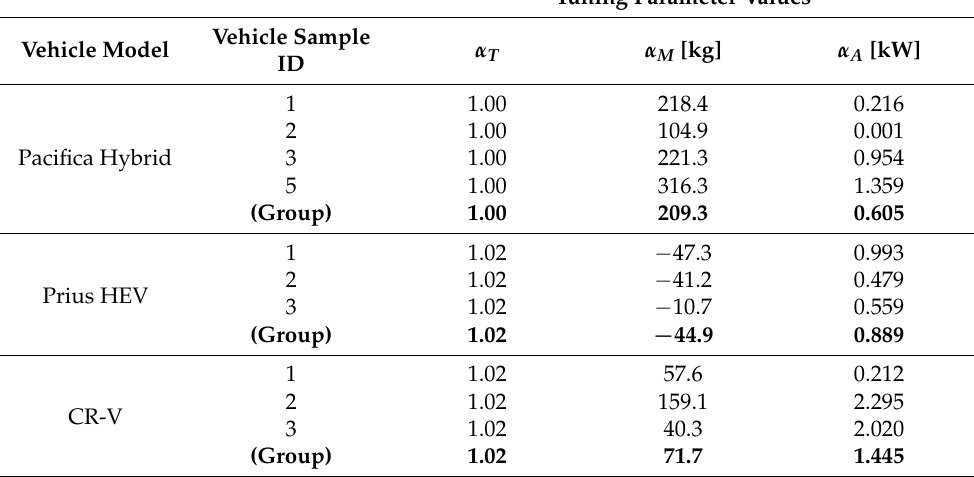
Tuning Parameter